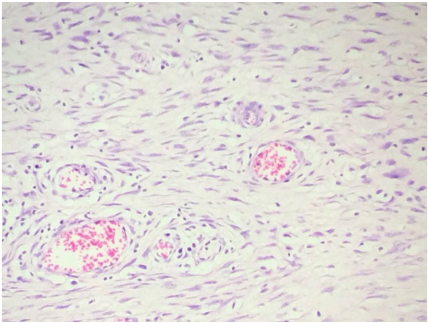
Figure 8: Interstitial and perivascular infiltrates by inflammatory